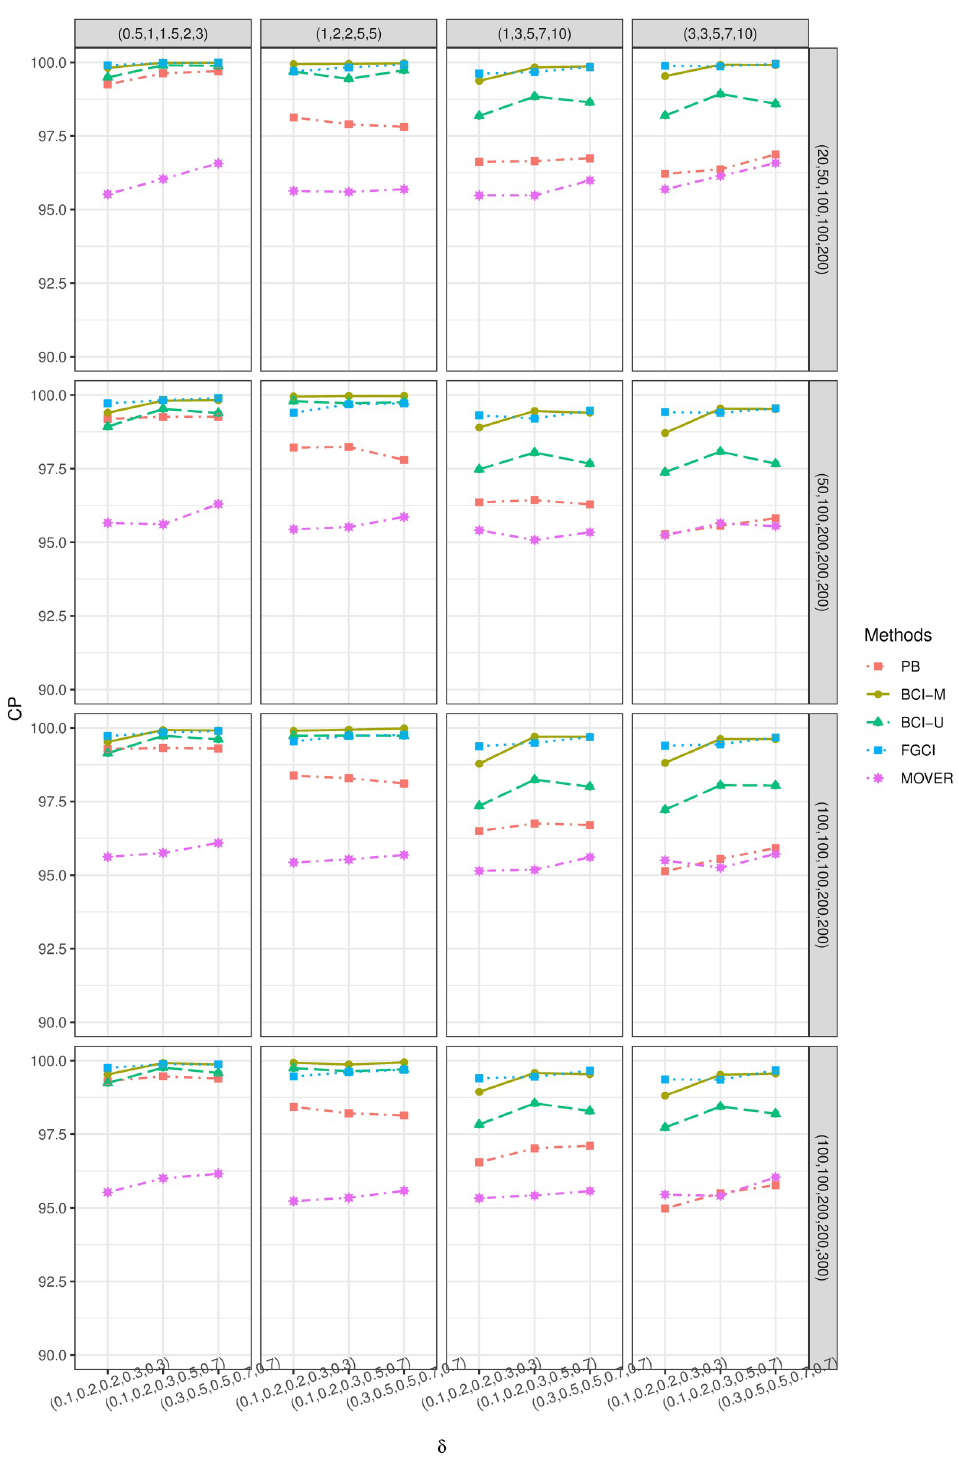
Fig 2. CP performances of 95%SCIs for θ jl : 5 sample cases.